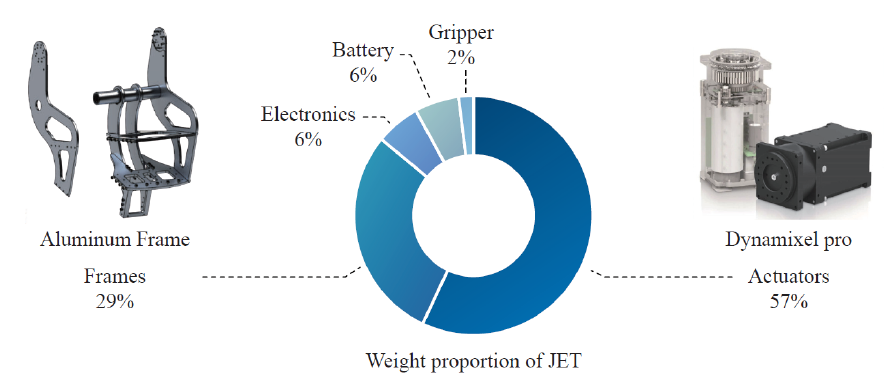
Figure 8. JET weight